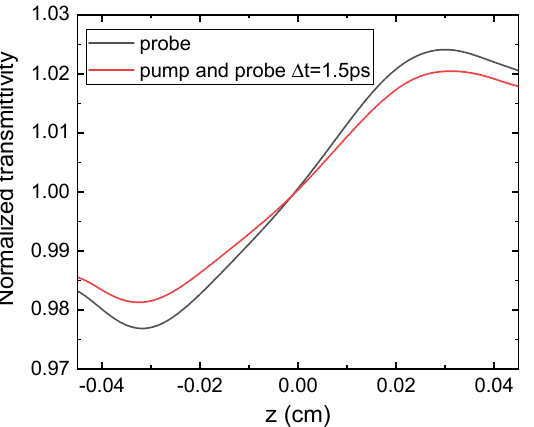
Figure 5. Modulated Z-scan trace measured on a CH 2 Br 2 sample with a pump–probe configuration (delay 1.5 ps) and with the probe beam alone.